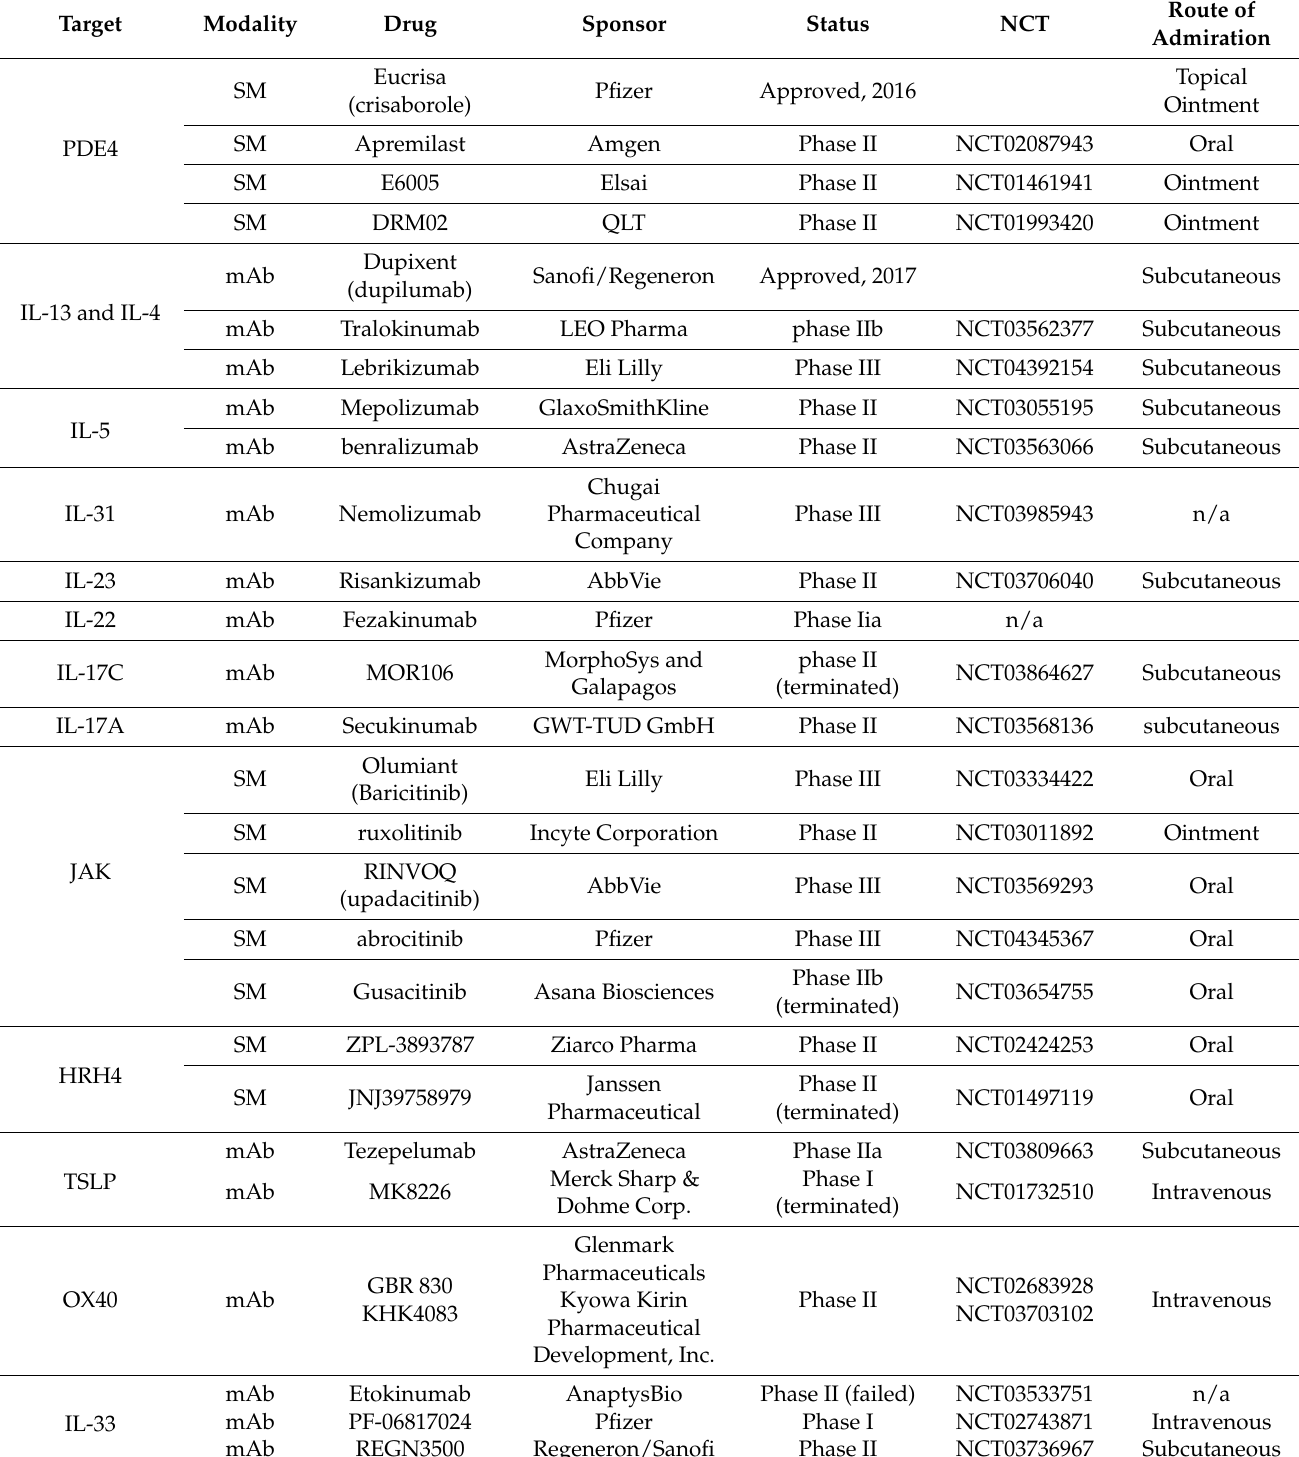
Table 6. Approved and investigational biologics and small molecules for